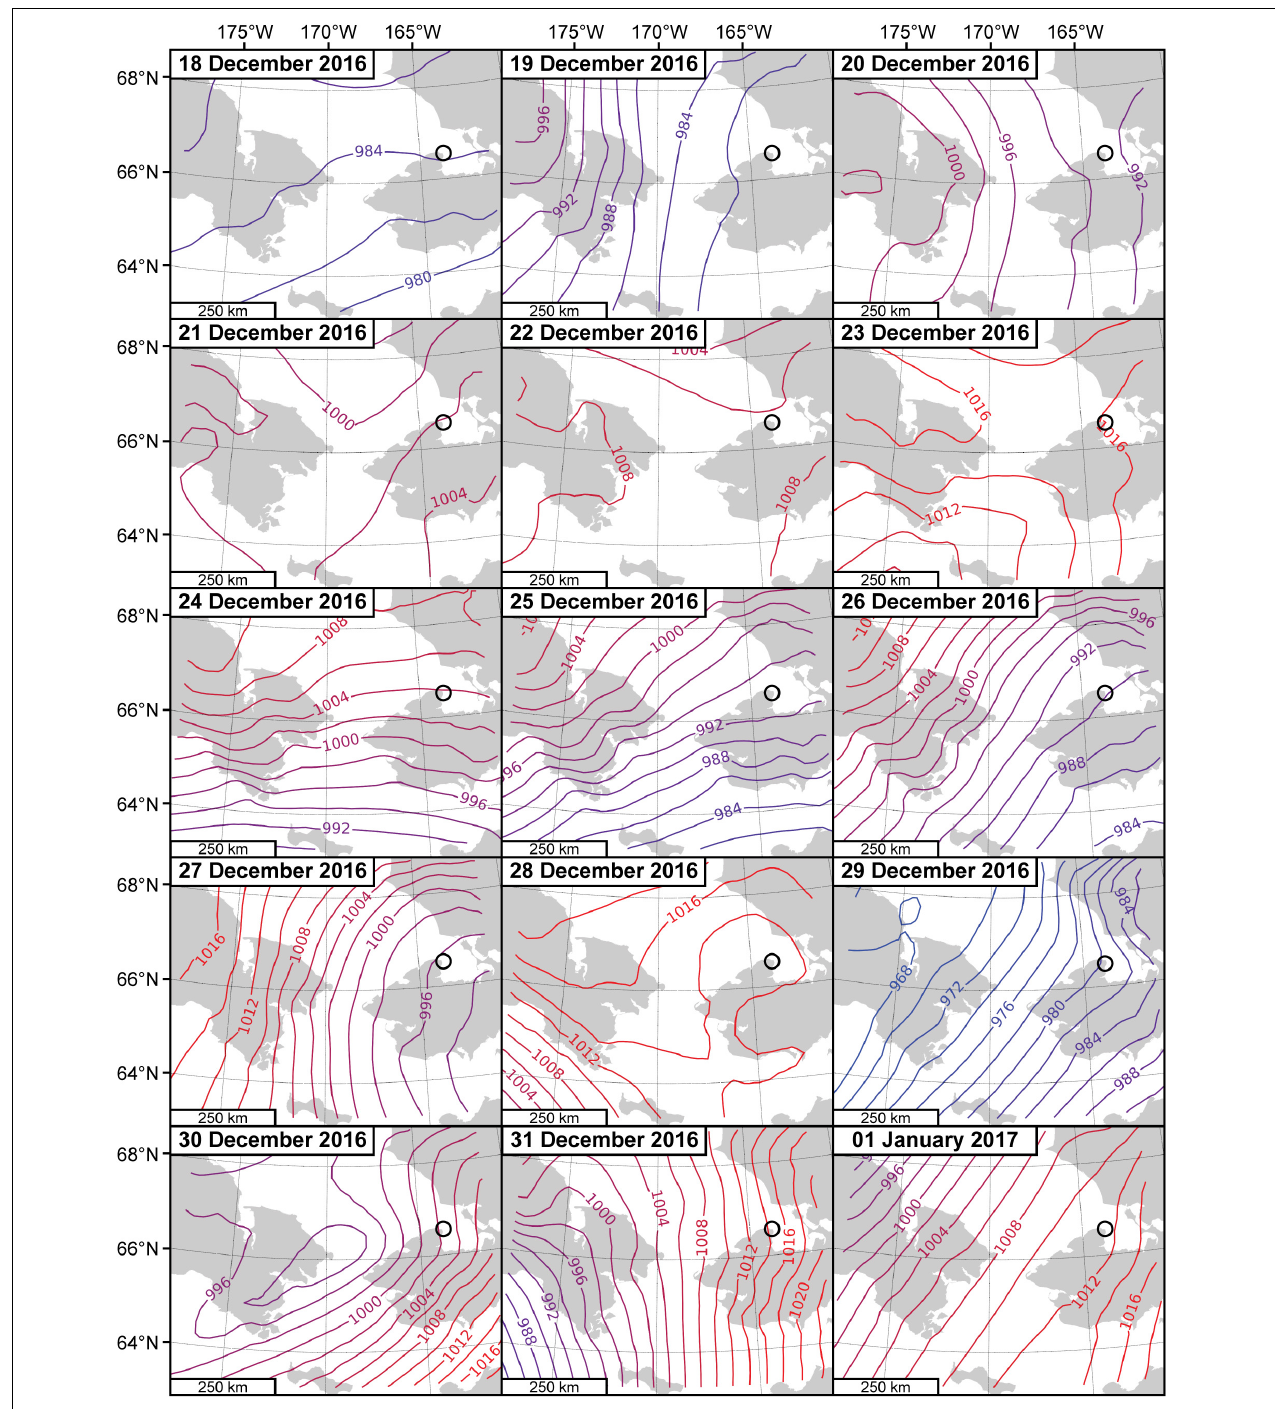
FIGURE 6 | Mean sea-level pressure (MSLP) contour maps derived from the ERA-5 atmospheric reanalysis provided by the European Centre for Medium-Range Weather Forecasts (ECMWF). MSLP is shown in hectopascals (hPa) at 2 hPa intervals between 18 December 2016 and 1 January 2017 (23:00 Zulu time each day). Lower pressure values are shown in cooler (blue) colors, whereas higher pressures are shown in hotter (red) colors. The location of Cape Espenberg is identified with the black circle. Notice the low pressures observed on both 19 December and 29 December that were major factors in the destabilization of shorefast ice and passage of the severe winter storm on 31